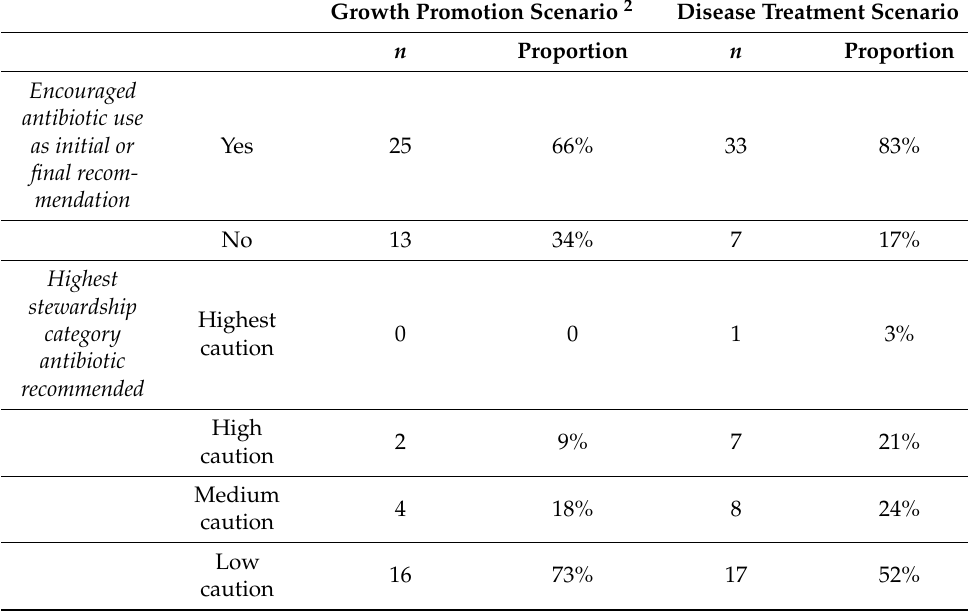
Table 4. Antibiotic recommendations by antibiotic stewardship category 1 .